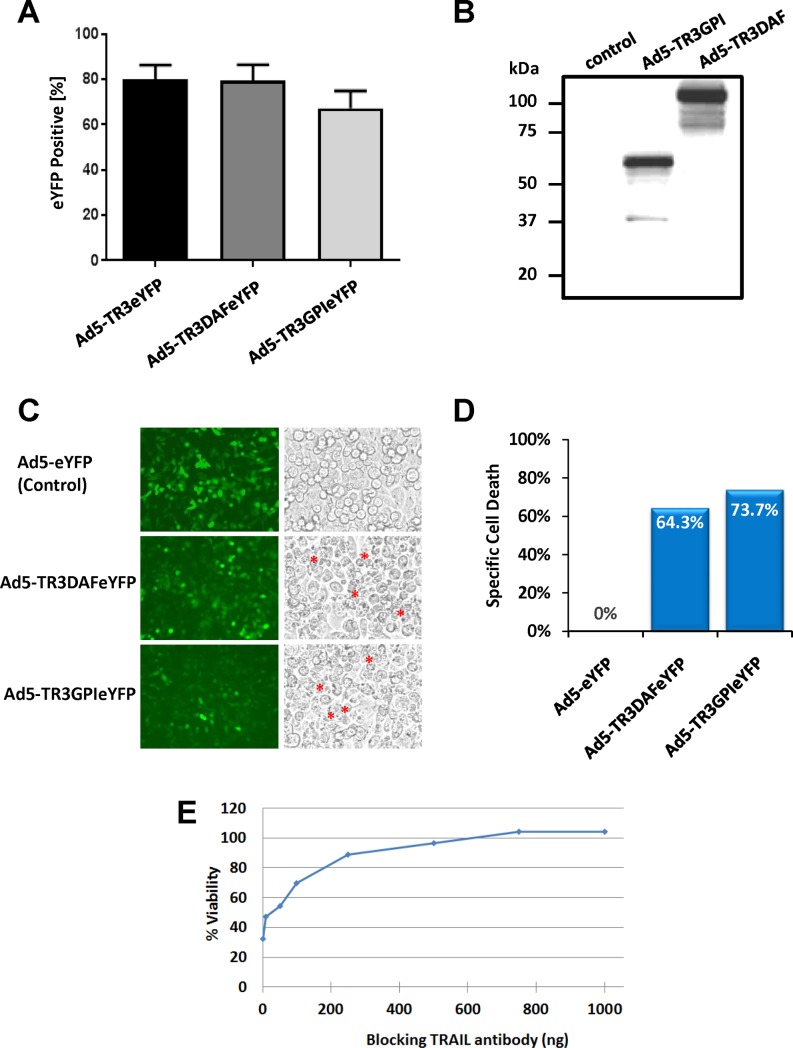
CHO-CAR cells expressing membrane-anchored TR3 variants induce cell-cell contact-dependent target cell death.(A) CHO-CAR cells were infected with the indicated Ad5-based viruses using MOIs that were determined to achieve equivalent transduction efficiencies during prior titration experiments. Infection of the cells with Ad5-eYFP (MOI 1000), Ad5-TR3GPIeYFP (MOI 5000) and Ad5-TR3DAFeYFP (MOI 8750) did indeed result in comparable transduction efficacies gauged on the proportion of YFP-positive cells using flow cytometry. (B) Western Blot analysis of infected CHO-CAR cell lysates confirmed the molecular weights of TR3GPI (~65 kDa) and TR3DAF (~130 kDa). (C) Functional TR3 activity was assessed employing a co-culture experiment with Jurkat suspension cells. Two hours later, and compared to the control (GFP), large numbers of apoptotic bodies were noted only on cells expressing the membrane-anchored TR3 variants (asterisks), indicative of widespread apoptosis induction. (D) Graphic representation of the overlay assay shown in (C), with specific cell death of ~64% mediated by expression of TR3GPIeYFP and ~74% by TR3DAFeYFP on the CHO-CAR effector cells determined by FACS analysis. (E) Blocking experiment using anti-TRAIL antibody to demonstrate mechanism of cell-cell contact-dependent mechanism of cell death. The contact-dependent killing capacity of TR3GPI-expresssing CHO-CARs (Ad5-TR3GPIeYFP) co-cultured with Jurkat suspension cells was dose-dependent and was completely abolished at the highest concentration of TRAIL-blocking antibody (> 600 ng).